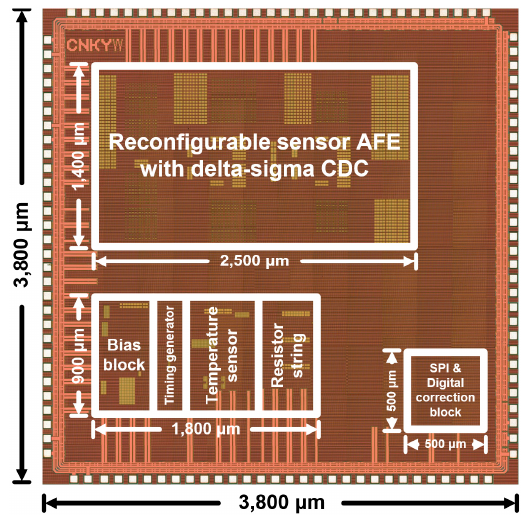
Figure 9. Die photograph of the proposed reconfigurable sensor analog front-end IC.